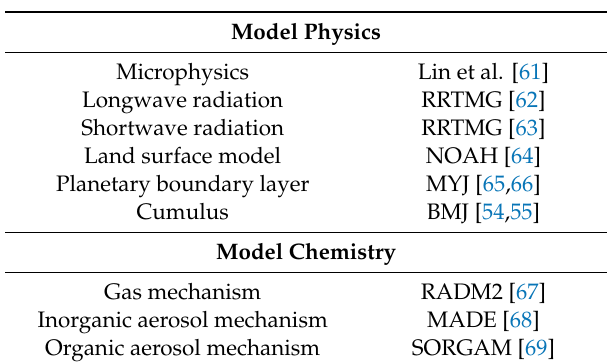
Table 1. Model physics and